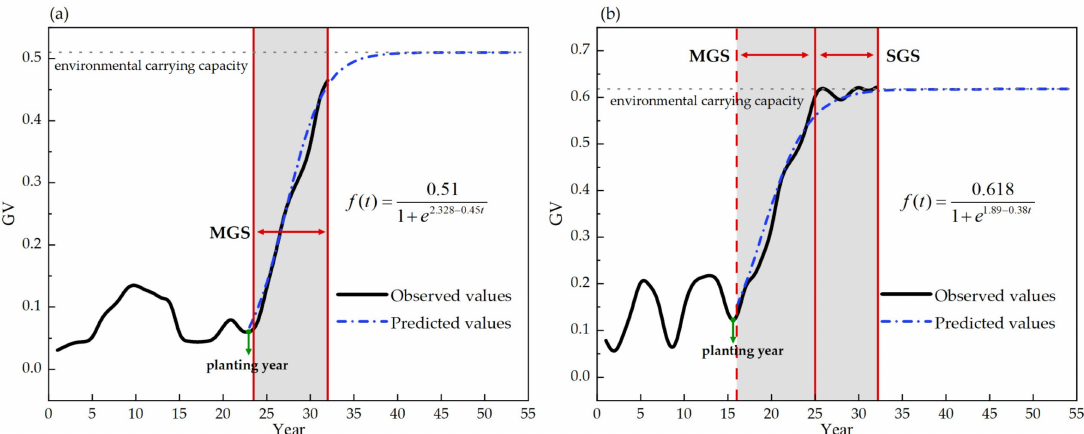
Figure 4. Schematic diagram of estimated planting age based on LGM. ( a ) Unidentifiable SGS. ( b ) Identifiable